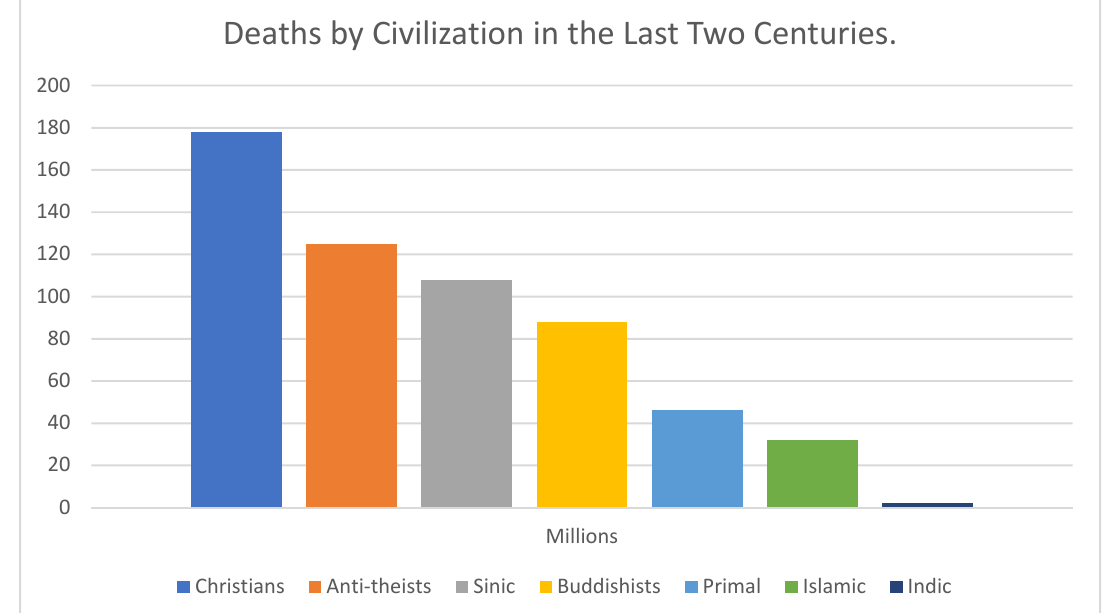
Figure 2. Deaths by Civilization in the Last Two Centuries.